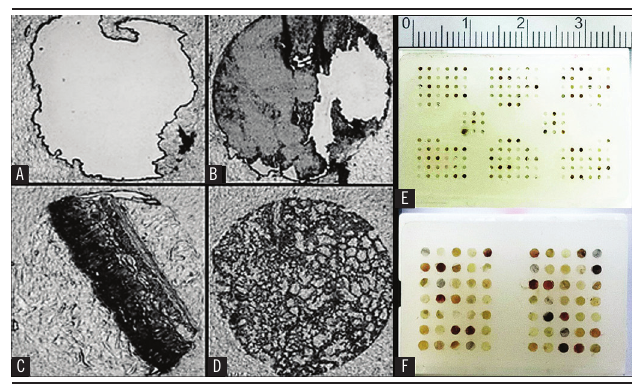
figurE 2 − Quality levels established for quantitative analysis of tissue samples The levels were organized in an increasing order of quality: A) value 0; B) value 1; C) value 2; D) value 3. TMA blocks built with polymer-enriched paraffin, submitted to the 37ºC block tempering protocol, associated with a tempering process and filled by 0.4 (E) and 1.5 mm diameter samples (F) with 1000 µm spacing between the tissues. TMA: tissue